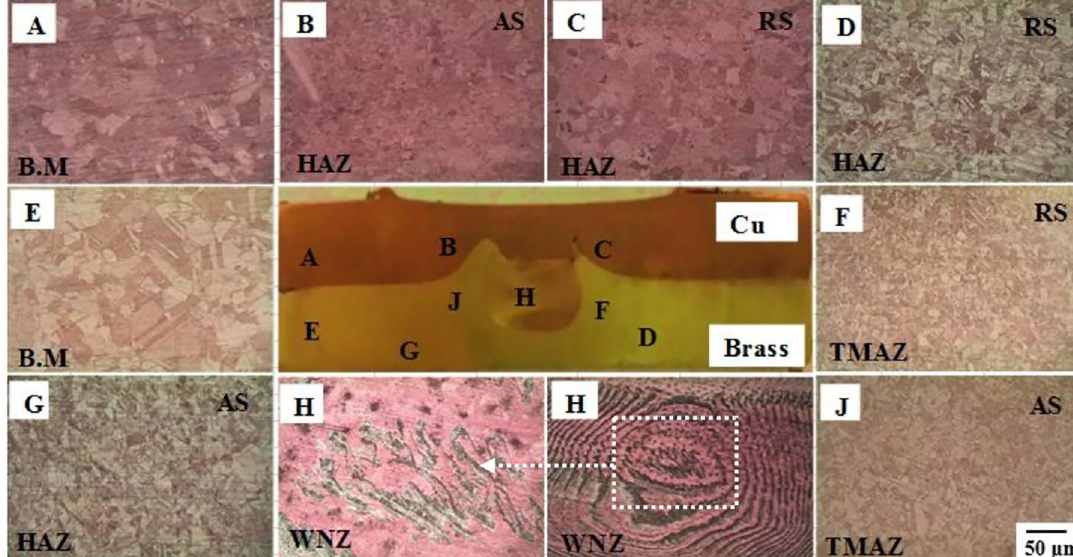
Figure 6. Optical macrostructure and microstructure of different weld zone in case A with the welding condition of 710 rpm and 25